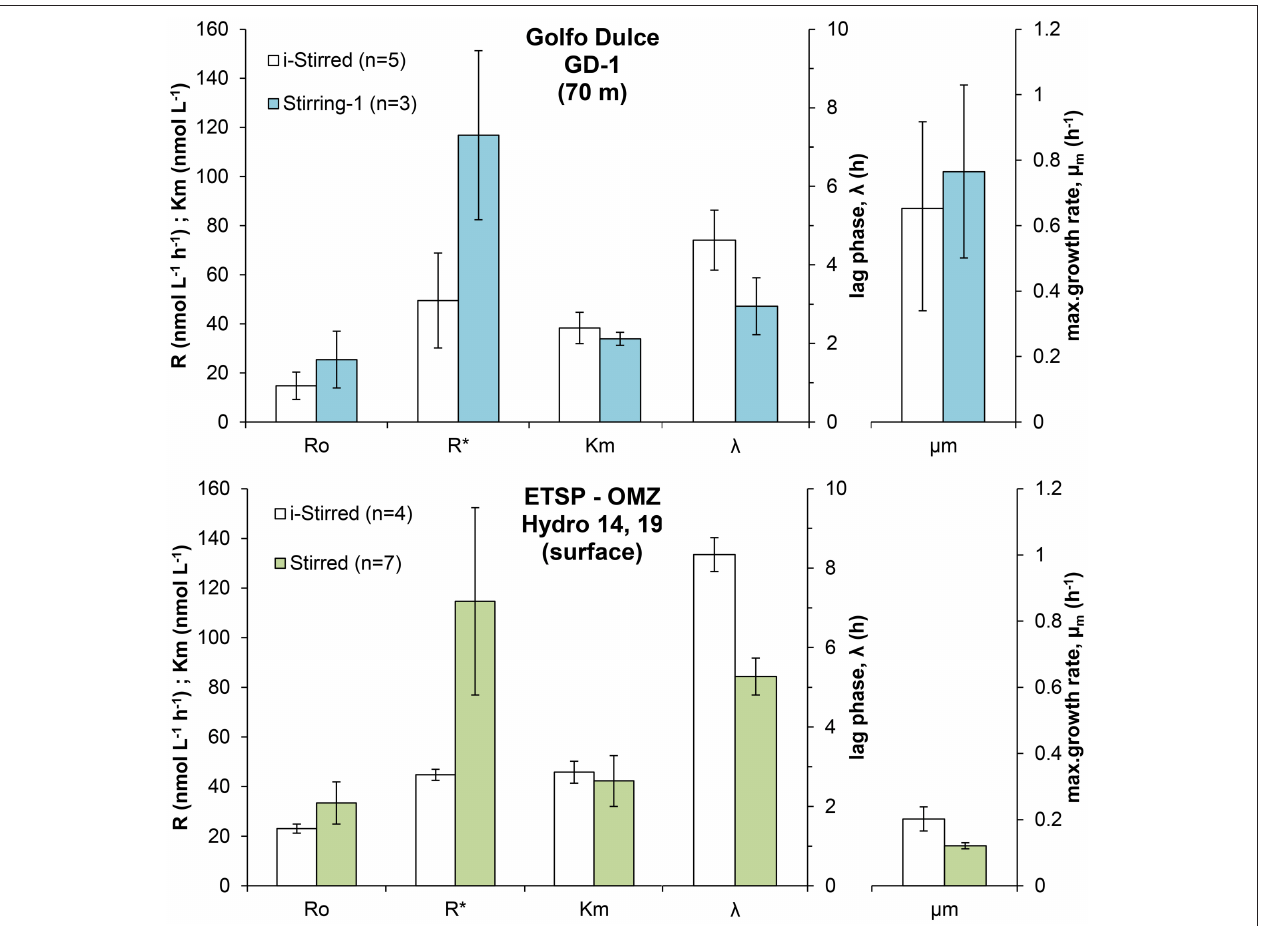
FIGURE 6 | Effect of stirring on the respiratory parameters during the incubation of intermediate waters in Golfo Dulce and surface waters in the ETSP OMZ off Chile/Peru: Initial respiration rates ( R 0 ), maximum respiration rate ( R *), half saturation constant ( K m ), lag-phase ( λ ), and maximum specific growth rate ( µ m ) measured during the incubations. Samples were sparged with inert gas to lower O 2 concentration and incubated with constant stirring (Stirred) or with intermittent stirring for 5min every 2–4h